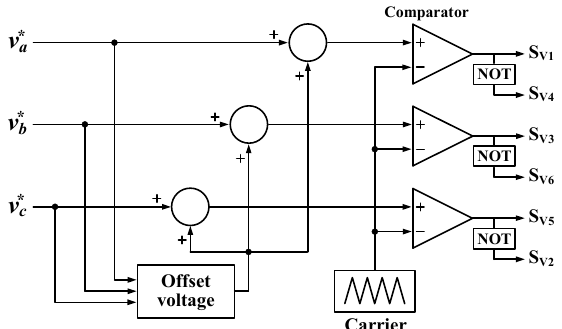
Figure 24. PI controller for grid current control.